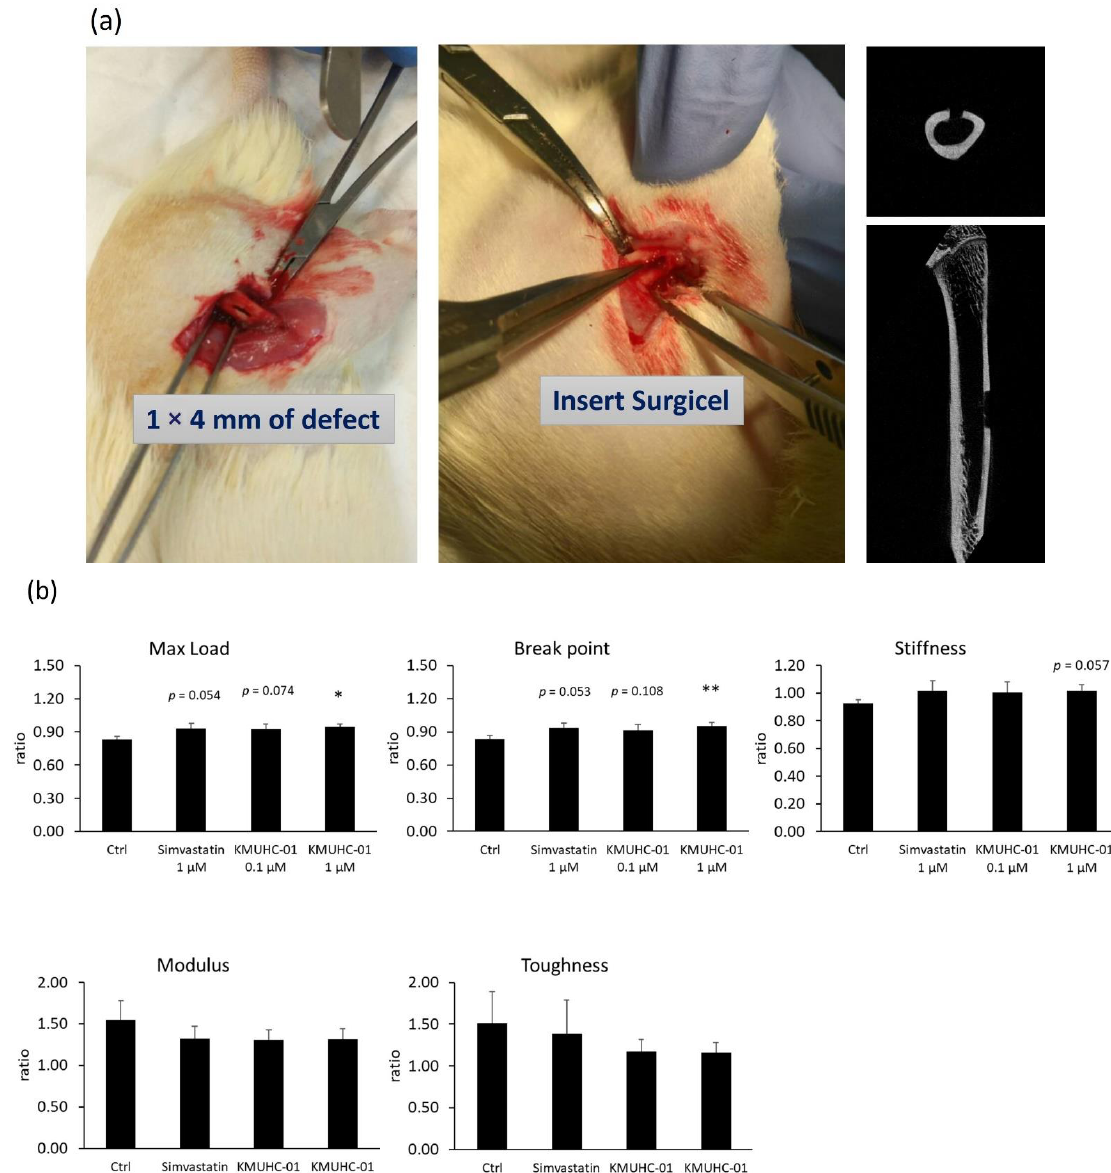
Figure 6. Rat femur bone defect treated with local simvastatin and KMUHC-01 injections. ( a ) A representative rat femur bone defect model is shown in the experimental photograph and the image of micro-CT postoperatively; ( b ) the biomechanics study of three-point bending tests to analyze the mechanical properties at the end of femur bone defect model (6 weeks postoperatively), which are expressed using the defect-to-nondefect femur ratio. (* p < 0.05; ** p < 0.01, comparison with control group).